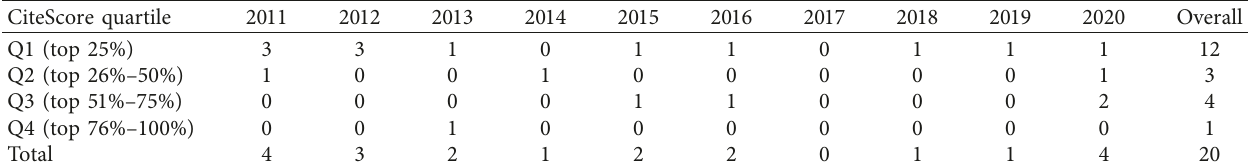
Table 4: Publications by journal quartile by CiteScore percentile of all types of caries vaccine publications. CiteScore